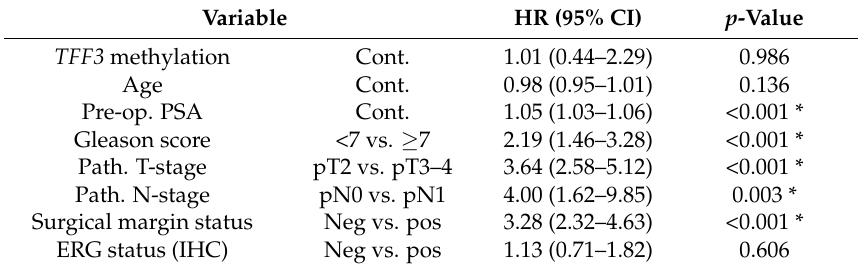
Table 3. Cox regression analysis of PSA recurrence-free survival after radical prostatectomy in our PC cohort ( n = 292). TFF3 methylation for CpG sites Nos. 6–8. Abbreviations: Path, pathological; T, tumor;